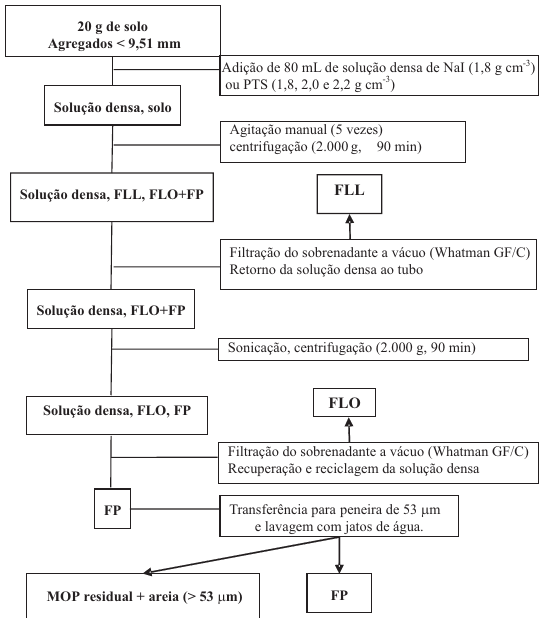
Figura 1. Esquema simplificado do fracionamento físico densimétrico com iodeto de sódio (NaI) e politungstato de sódio (PTS) visando a separação da fração leve-livre (FLL), fração leve-oclusa (FP), fração pesada (FP) e da fração particulada residual (MOP residual) de granulometria tama- nho